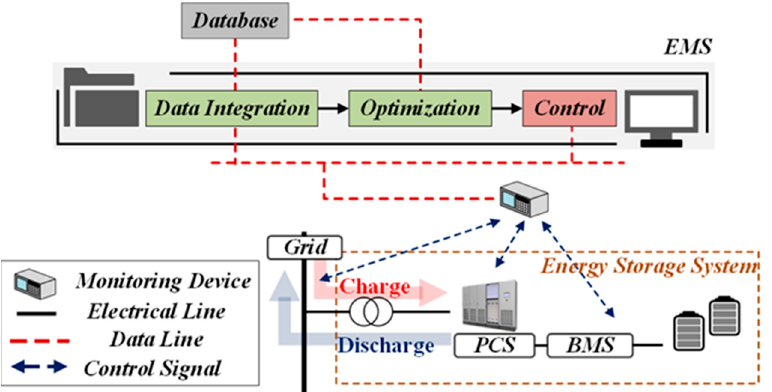
Figure 1. Configuration diagram of an energy storage system (ESS).